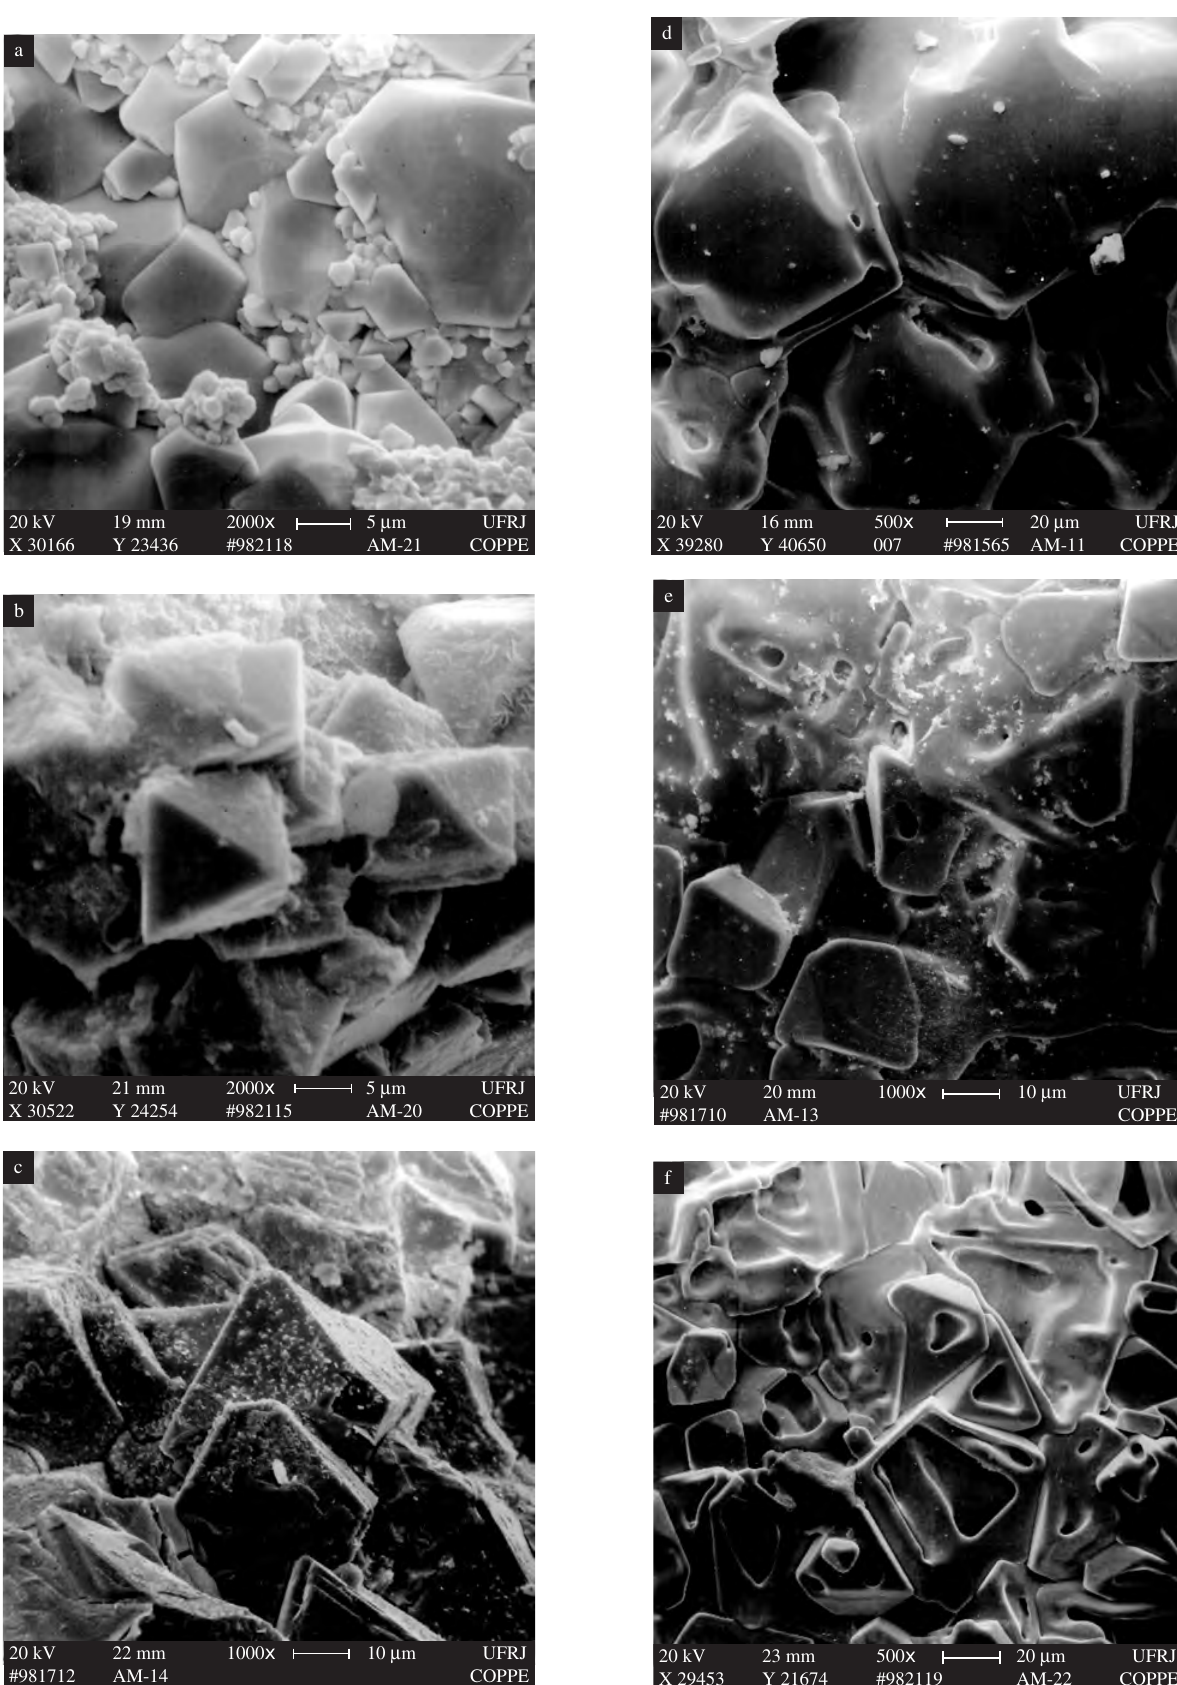
Figure 3. Micrographs of cobalt-zinc ferrite rings sintered for 5 hours at: a) 950 °C; b) 1100 °C; c) 1200 °C; d) 1300 °C; e) 1350 °C; and f) 1400